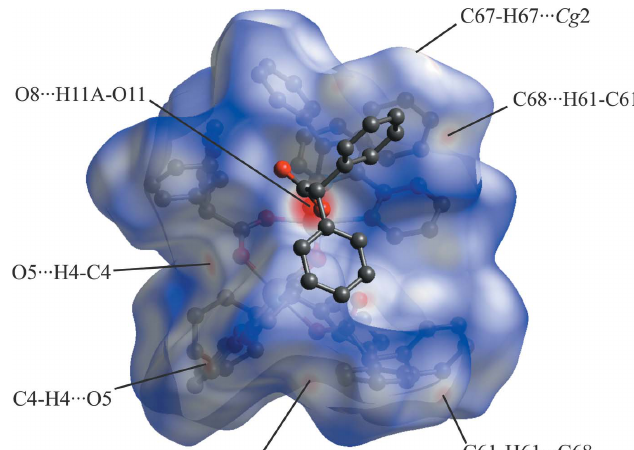
Figure 7 The Hirshfeld surface mapped over d norm for compound 2 in the range (cid:3) 0.7804 to 1.5753 a.u.